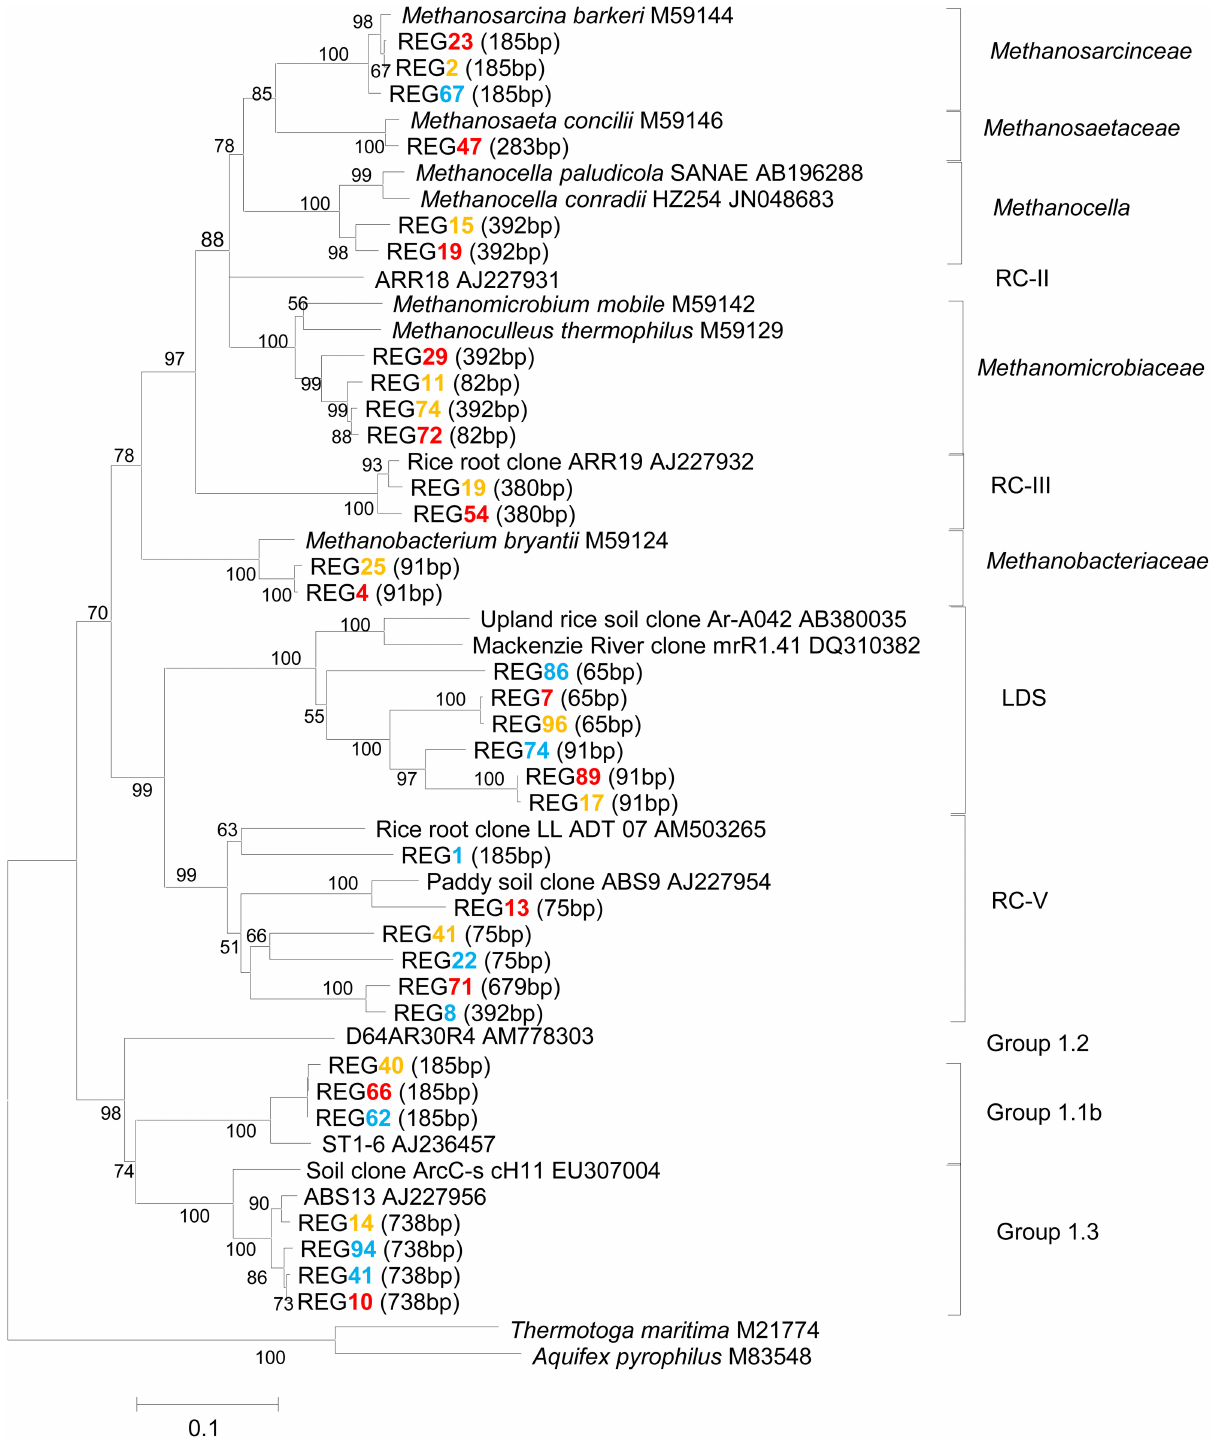
were used for constructing the phylogenetic tree. The scale bar represents 10% sequence divergence. GenBank accession numbers of the reference sequences are indicated and in silico T-RF sizes are given in parentheses. Bootstrap values (%) were generated from 1000 replications and indicated at individual